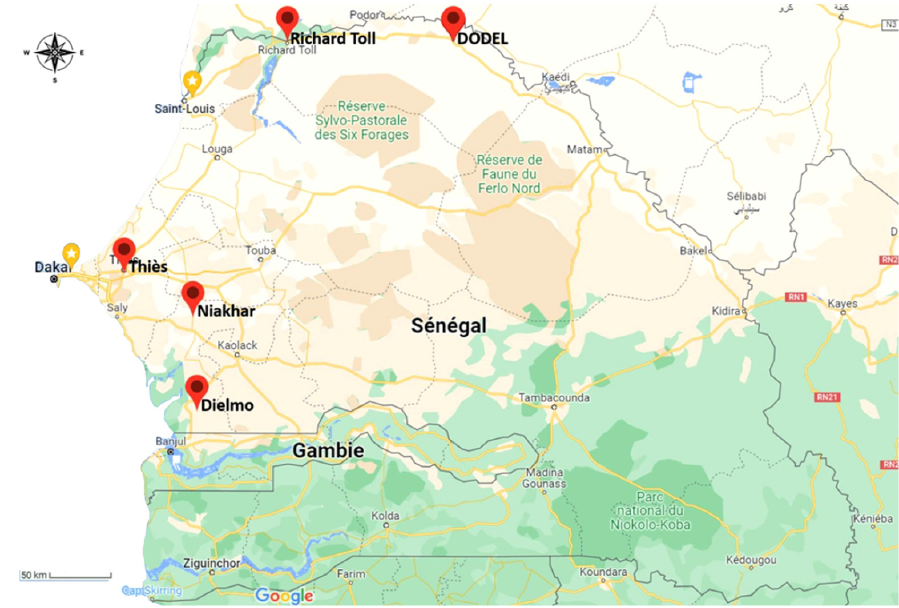
Figure 1. Location of the Dodel commune in the Saint-Louis region in Senegal.